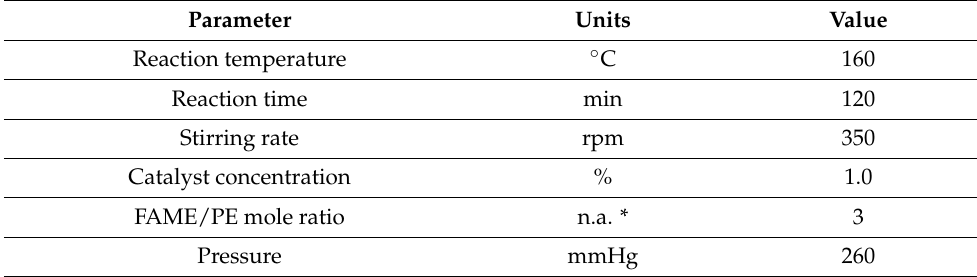
Table 8. Chemical conditions selected for biolubricant